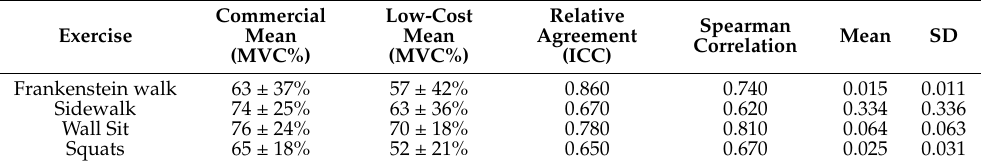
Table 4. Dynamic exercise at mean